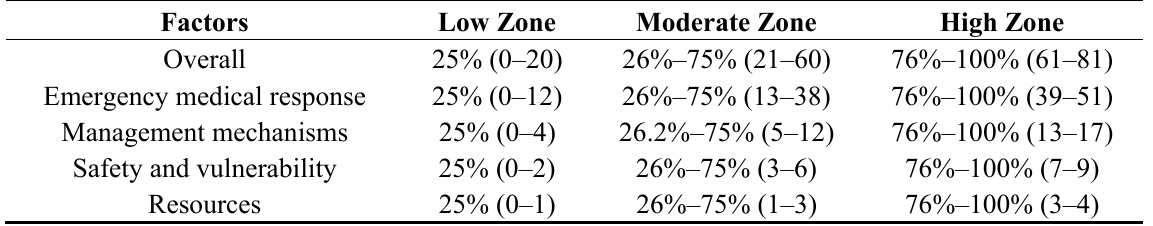
Table 4. Scale card for self-evaluation and categorization of the level of hospital